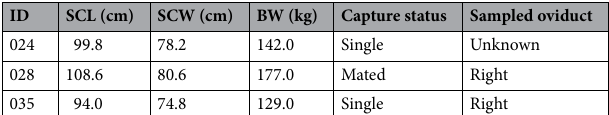
Table 1. Harvested animals. SCL straight carapace length, SCW straight carapace width, BW body